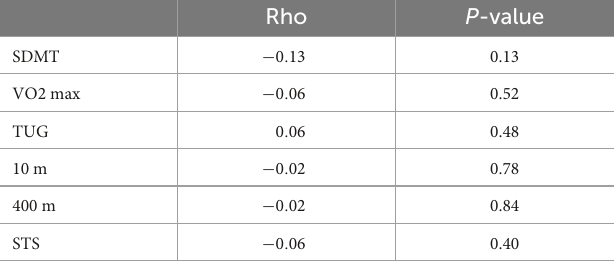
TABLE 3 Correlations between serum NfL and clinical